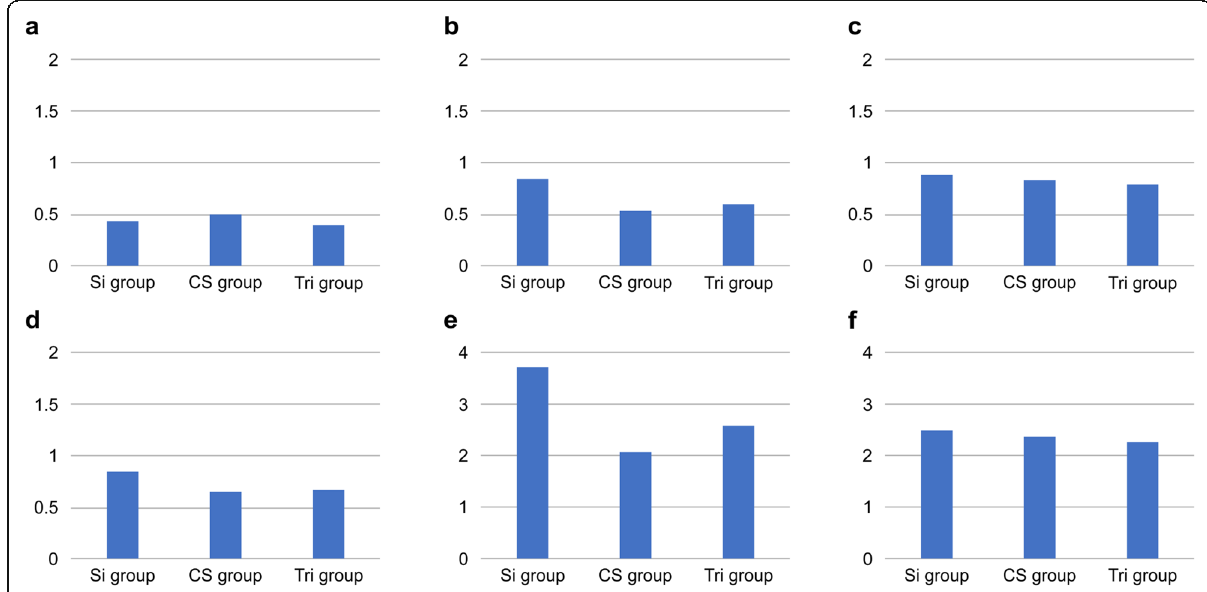
Fig. 6 Accuracy of tooth/mucosa-supported surgical guides. a Three-dimensional (3D) deviation at the crest in 45. b 3D deviation at the crest in 47. c 3D deviation at the apex in 45. d 3D deviation at the apex in 47. e Angular deviation in 45. f Angular deviation in